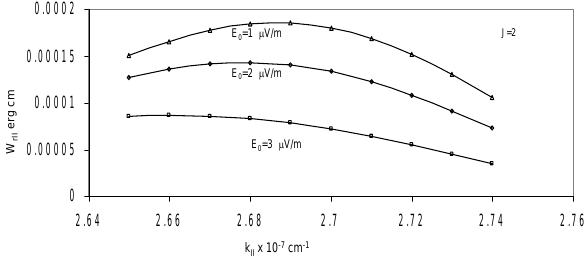
Fig. 11. Variation of parallel resonant energy Wr II erg cm versus wave vector k II cm − 1 for different values of parallel electric field Fig:-8 Variation of parallel resonant energy WrIIerg cm versus wave vector kIIcm -1 for different values of parallel electric Fig.11 Variation of parallel resonant energy Wr II erg cm versus wave vector k II cm-1for different values of field EII,anddistribution index J=1. parallel electric field E 0 , and distribution index J = 1. E 0 , and distribution index J=1.